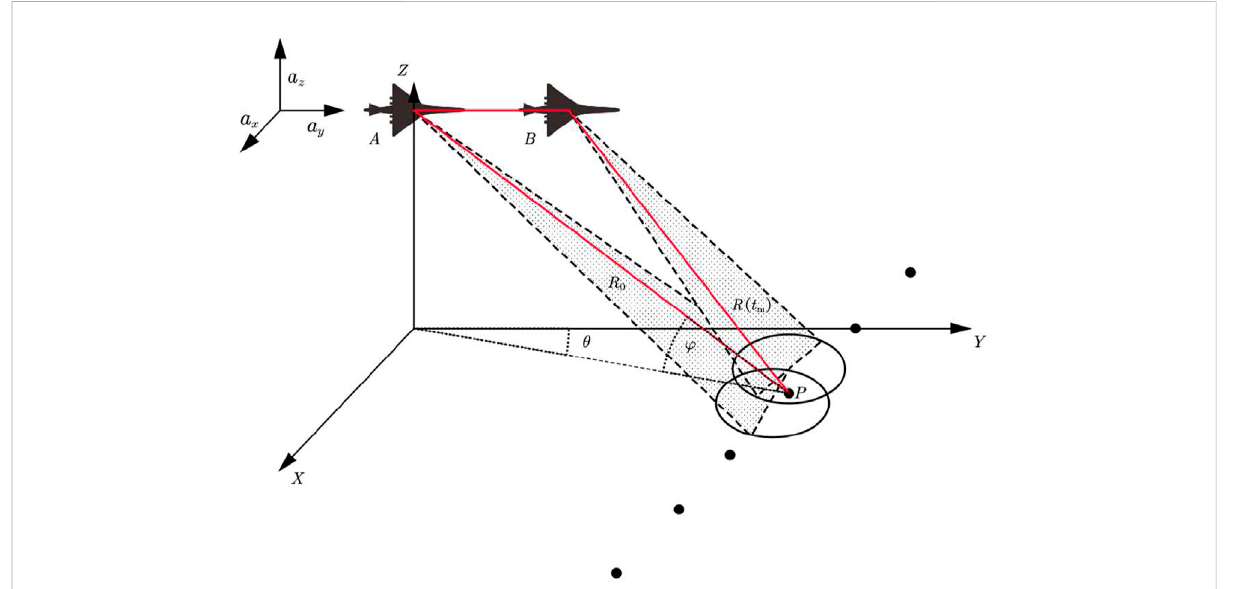
FIGURE 1 A geometric model for forward-looking imaging of a uniformly accelerated